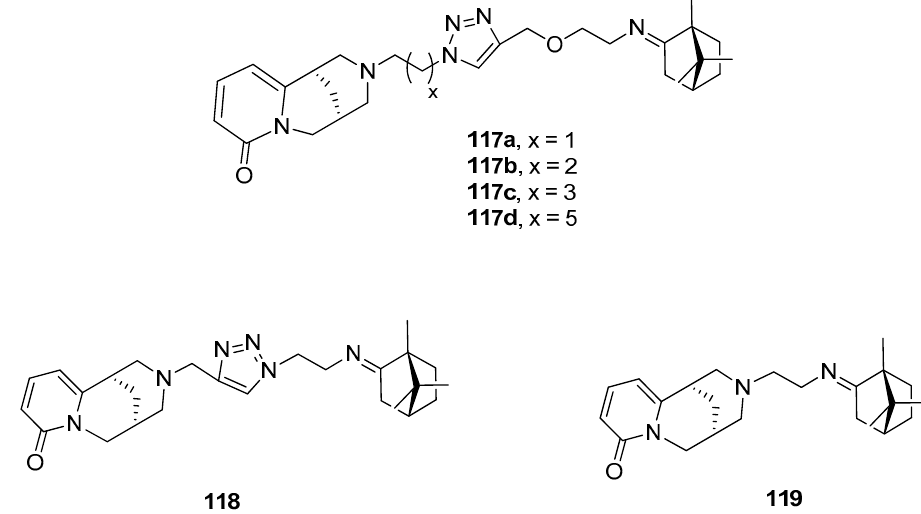
Figure 30. (+)-Camphor based (–)-cytisine with the heterocyclic fragment.